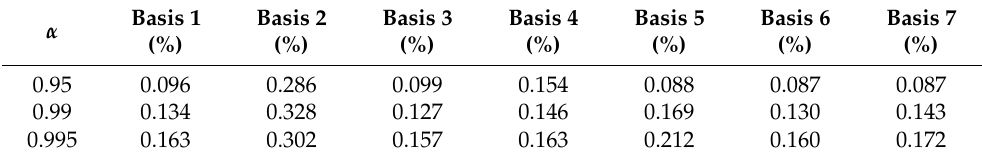
Table 3. rRMSE of estimated VaR in Portfolio 1.